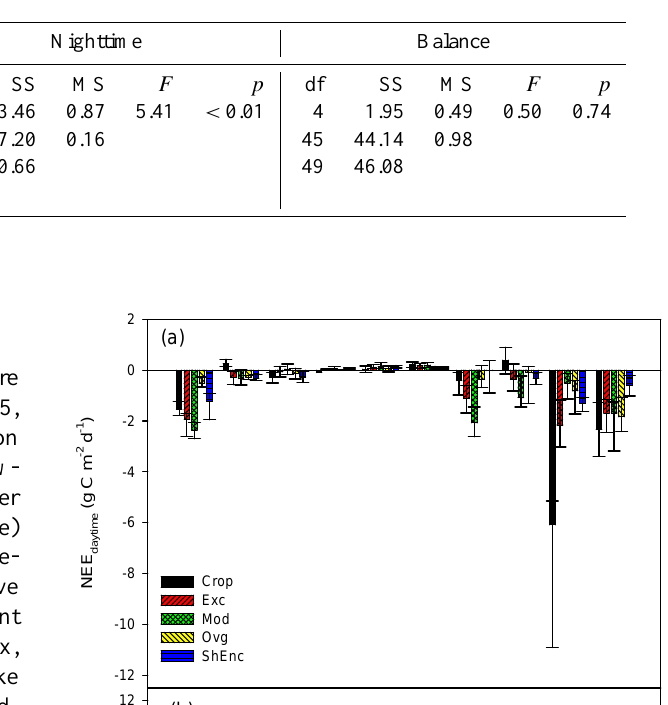
0 µmol m − 2 s − 1 . Based on the similar conditions, we as- sumed that monthly NEE rates for the two missing months were also carbon neutral allowing us to estimate an annual C balance. the fluxes (NEE daytime + NEE nighttime ; overbar denotes annual